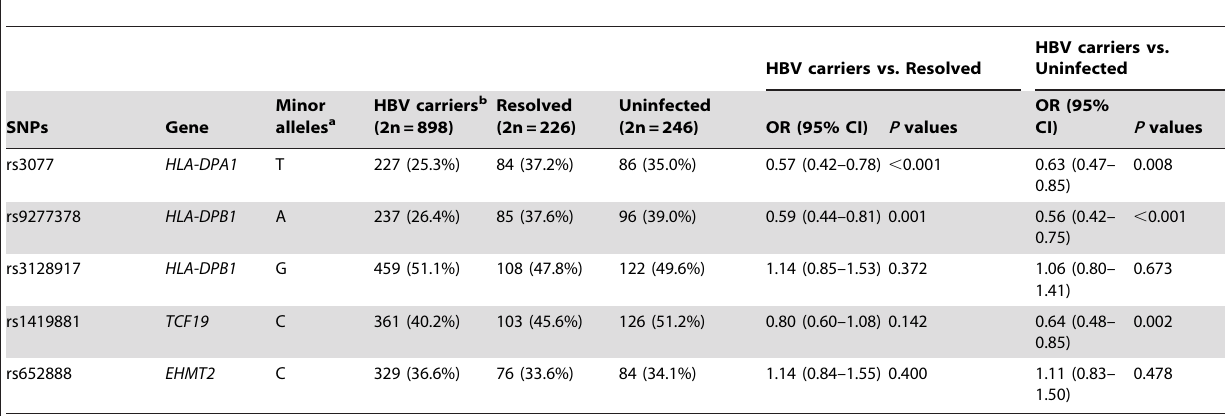
Table 2. Minor allele frequencies in HBV carriers, resolved HBV and uninfected subjects in